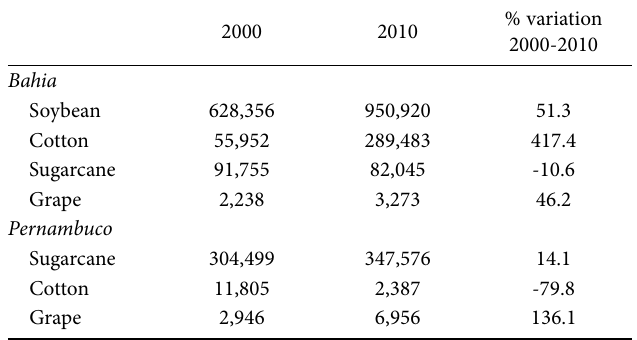
Table 1. Land allocation to the main commodities grown in Bahia and Pernambuco